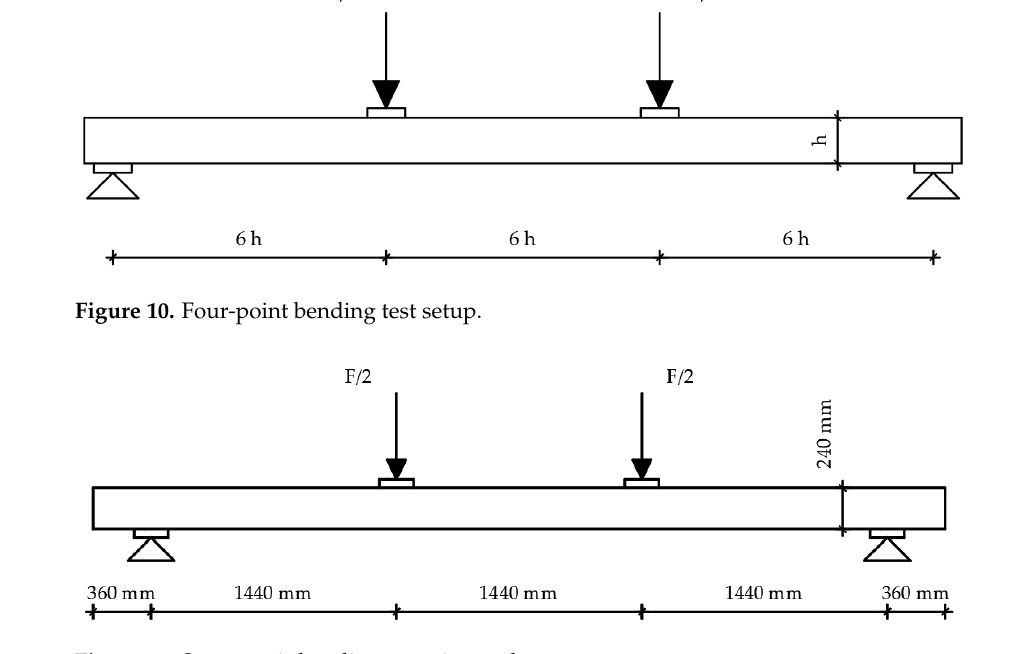
Figure 11. Strong-axis bending experimental test setup.